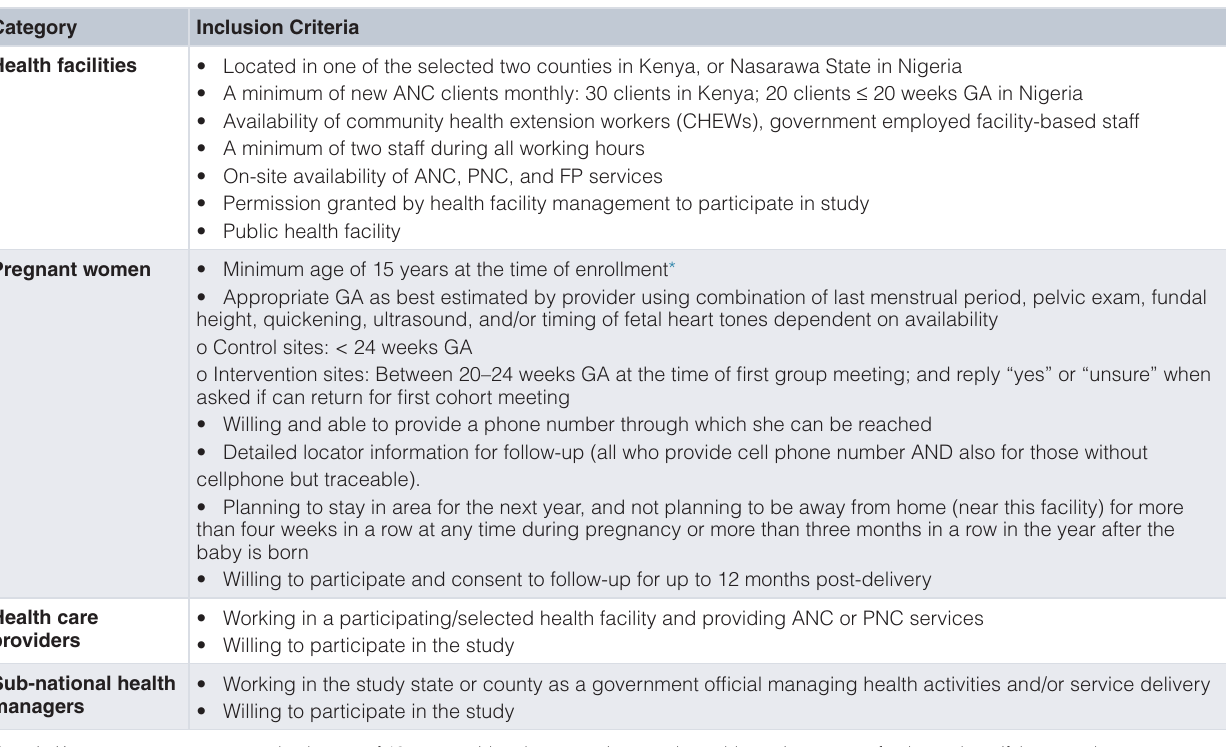
Table 2. Eligibility for health facilities and participants. Description of the inclusion criteria for health facilities and participants included in the study.